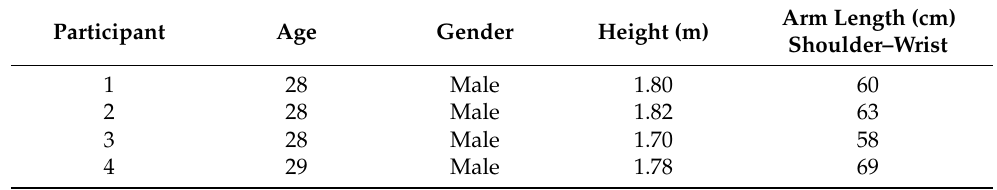
Table 1. Anthropometric information of the participants.